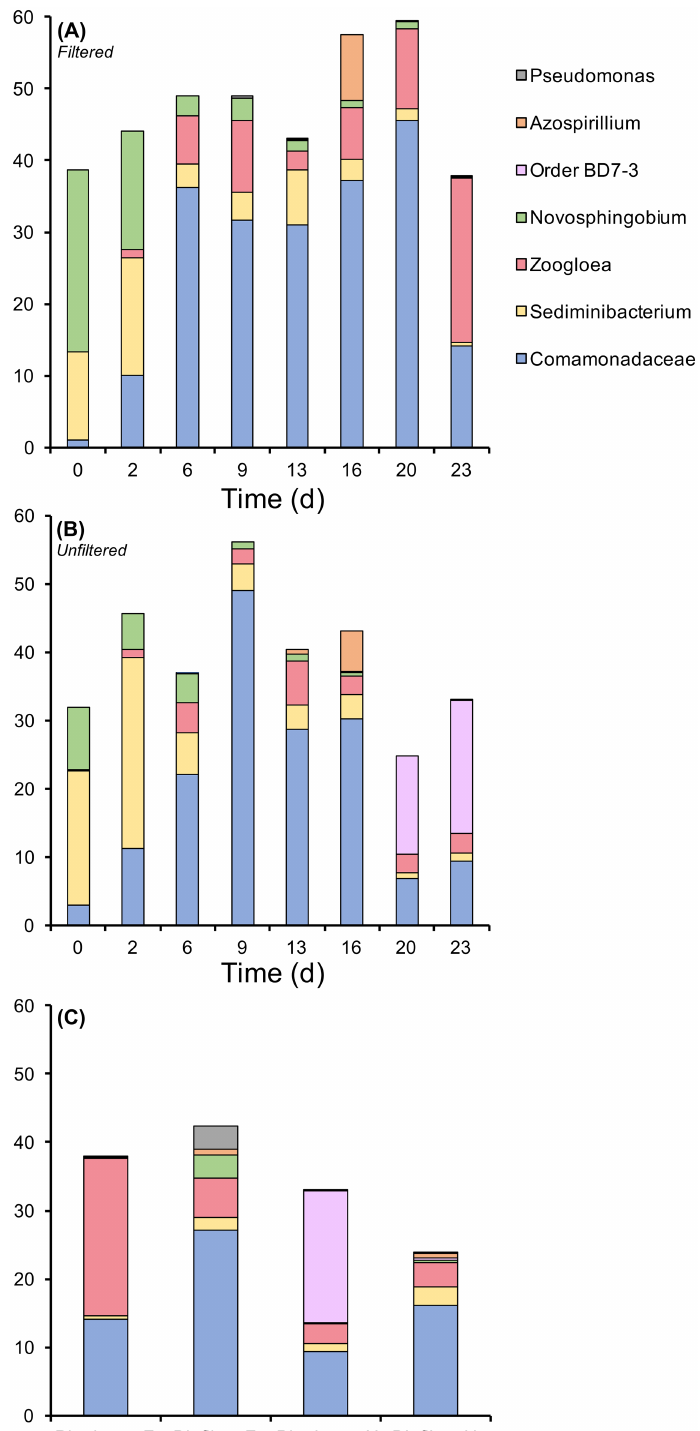
Fig 3. Most abundant bacterial OTUs. The top 20 most abundant OTUs, combined into the same taxon if classified similarly, for planktonic communities in filtered (Panel A) and unfiltered treatments (Panel B) over time, and within plankton and biofilm communities at the end of the experiment (day 23; Panel